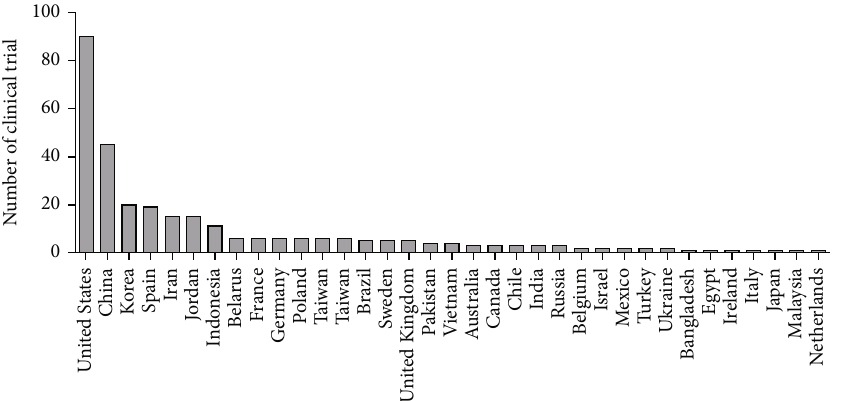
Figure 3: Frequency of country contributions in clinical trials on mesenchymal stromal/stem cell-based therapy during 2016-2020 (U. S. National Library of